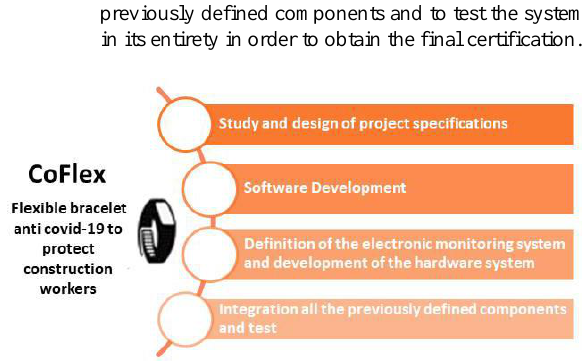
Figure 4 : Methodological approach